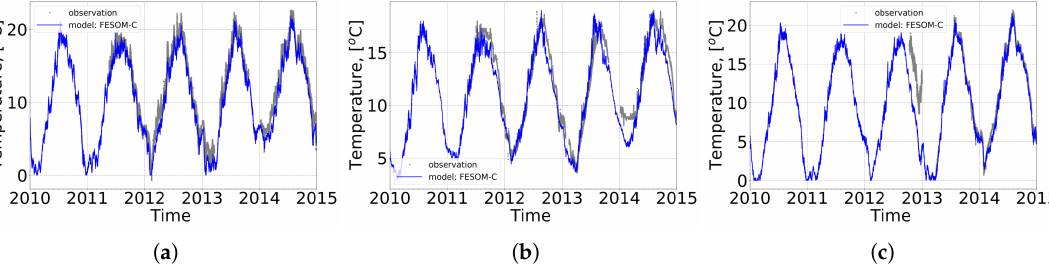
Figure 5. Observed (grey dots) and modeled (blue line) sea surface temperature at three stations: